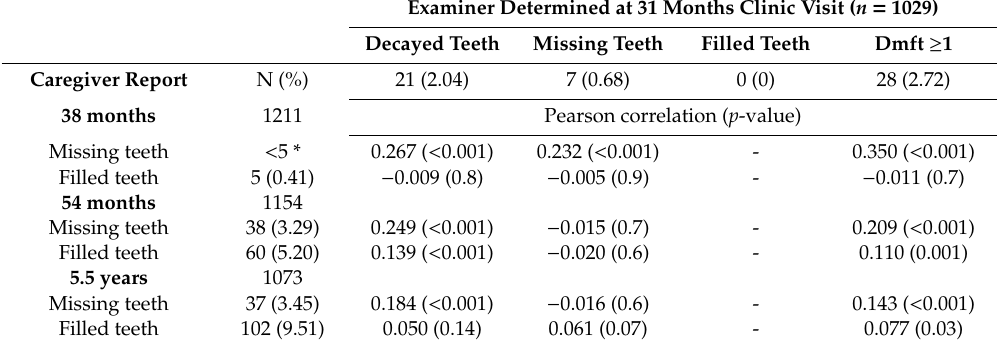
Table 2. Measures of correlation between caregivers’ assessments of children’s dental disease status at 38 months, 54 months and 5.5 years and clinically determined oral disease status at 31 months of